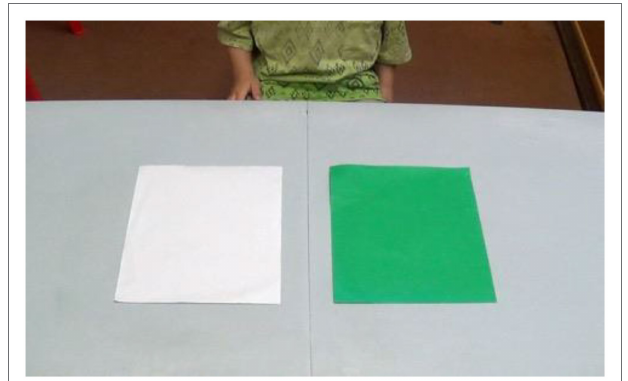
FIGURE 3 | The grass or snow task. Children were required to point to the green square when the experimenter say “snow” and to the white square when the experimenter said “grass.”